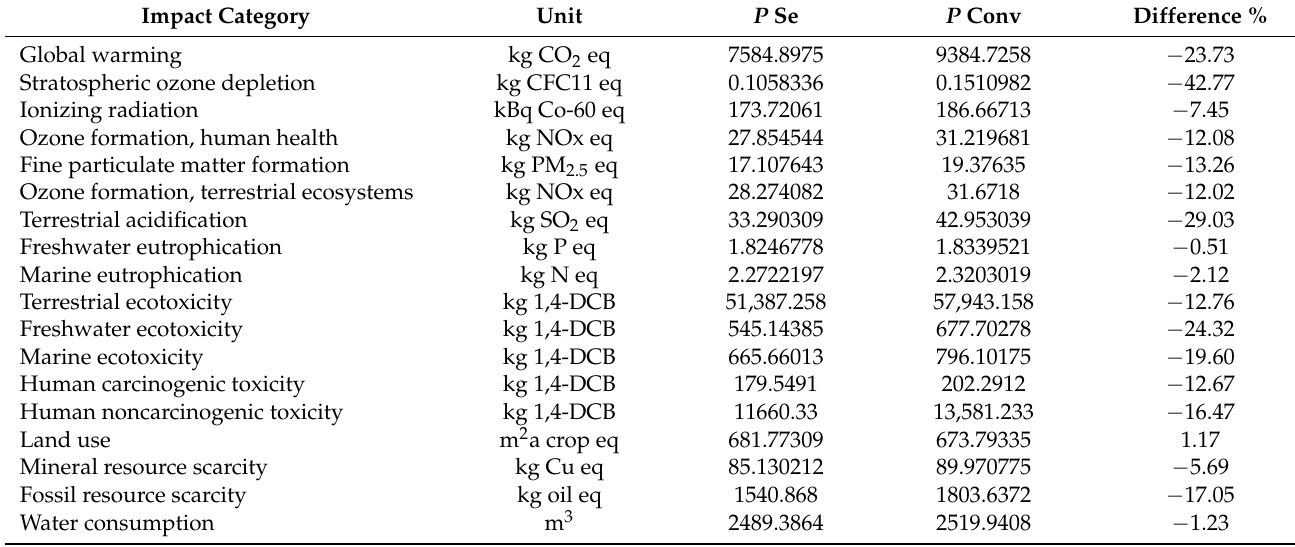
Table 2. Characterization factors and environmental impact per unit of stressor in selenium and conventional potato cultivation